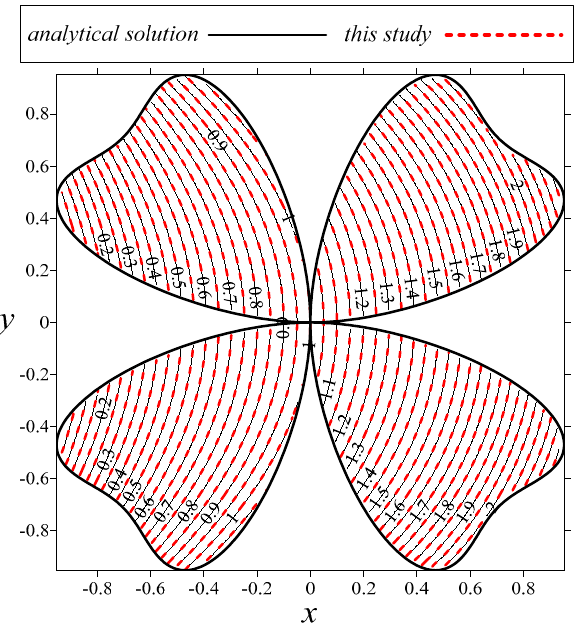
Figure 12. The number of terms of the radial polynomial basis function versus maximum absolute error.